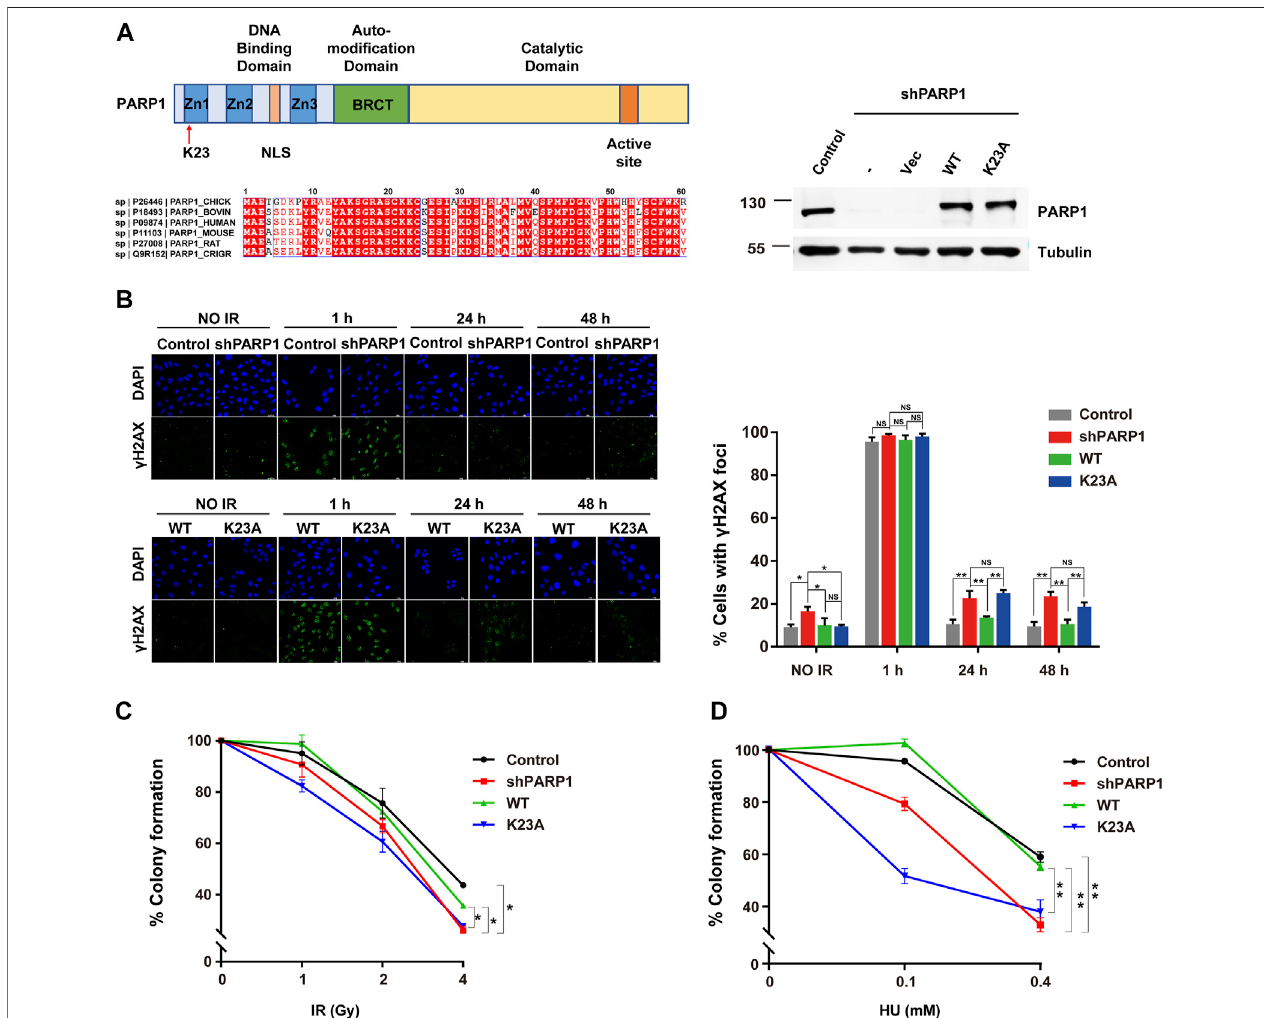
FIGURE 4 | PARP1 K23 mono-methylation functions in the IR-induced DNA damage response. (A) Left: Upper panel: scheme of three major domains of the PARP1 protein. Zn1, Zn2, Zn3: Zing fi ngers; NLS: Nuclear localization signal; BRCT: BRCA1 C-terminus like; K23 site is where the red arrow directs. Lower panel: Alignment of the fi rst 30 amino acids of PARP1 genes from 6 organisms. Right: PARP1 levels in PARP1 knockdown (shPARP1) and WT or K23A reconstituted U2OS cells. (B) DNA damage repair shown as the recovery of IR-induced γ H2AX foci. Representative γ H2AX foci at the indicated times after irradiation (2 Gy) are presented(leftpanel).Cellswith > 5 γ H2AXfociwerecountedforquanti fi cation.Quanti fi cation(rightpanel)istheaverageofthreeindependentexperiments(100cellsper experiment), presented as the mean ± SD, two-tailed Student ’ s t test, * p < 0.05. Scale bar: 40 μ m. (C) Colony formation assay of U2OS stableline cells treated with